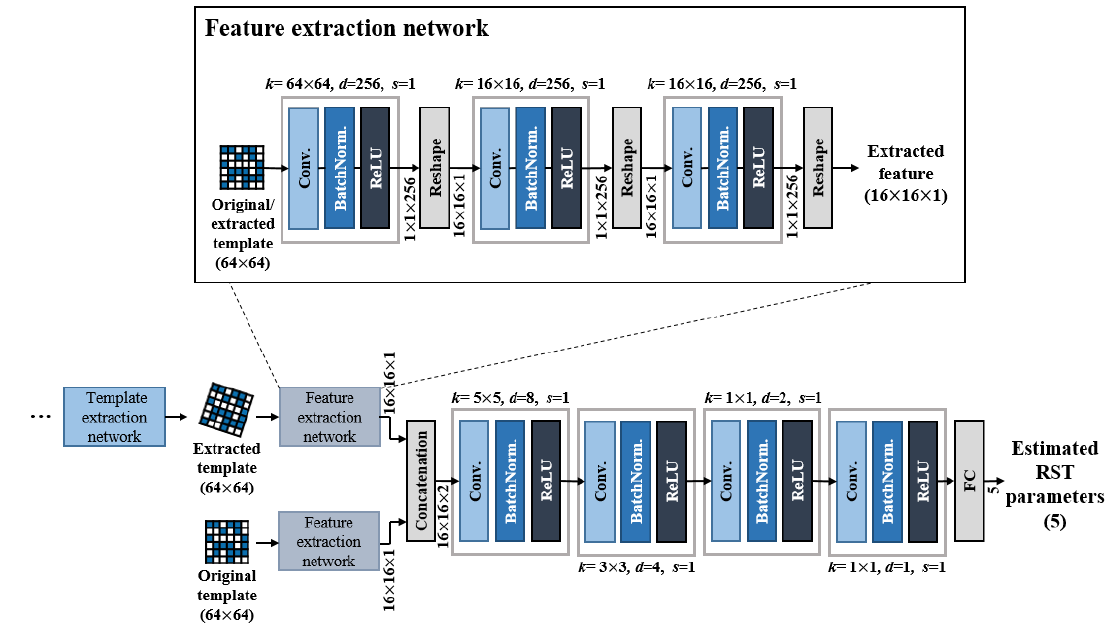
Figure 5. Template matching network architecture. Two feature extraction networks share weights with each other. k means kernel size, and zero-padding is not used in matching